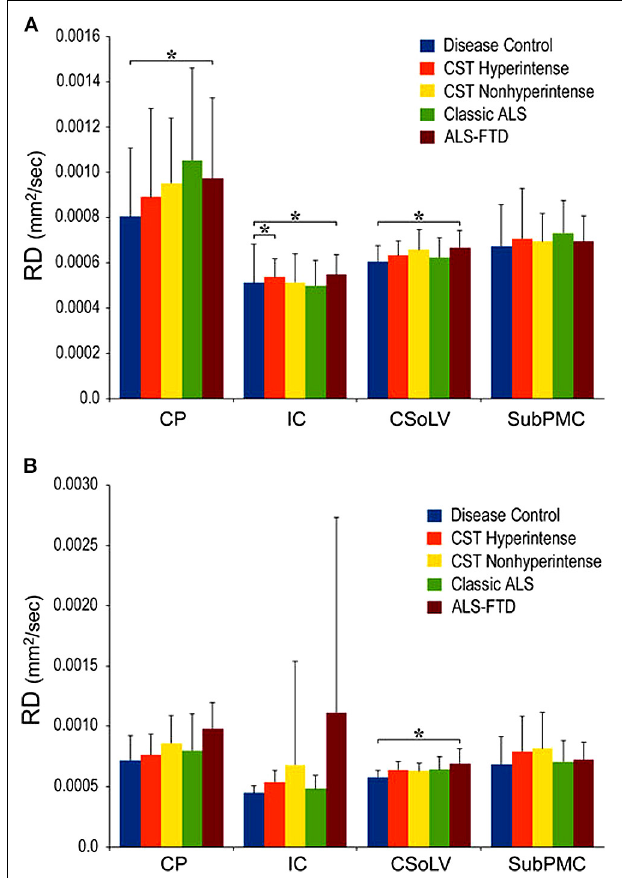
FIGURE 5 | Radial diffusivity (RD) values at four CST levels in right (A) and left (B) hemispheres of ALS patients compared to controls showing significant differences as ∗ P < 0.05. CP, cerebral peduncle; IC, posterior limb of internal capsule; CSoLV, centrum semiovale at top of lateral ventricle; subPMC, subjacent to primary motor cortex. Reproduced with permission from Springer Nature.